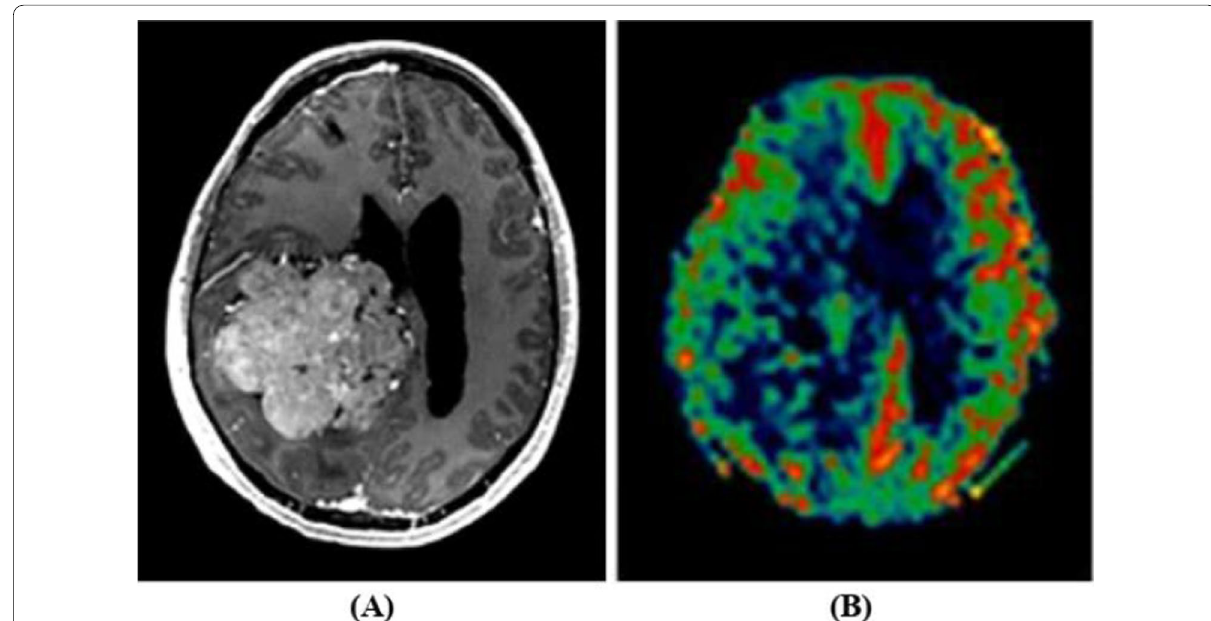
Fig. 8 MRI of hypovascular meningioma: A Axial T1 post contrast MRI showing intensely enhancing intraventricular meningioma. B Color coded ASL perfusion showing hypo perfusion of the lesion with nCBF of 0.7 ml/100gm/min, proved surgically to have low